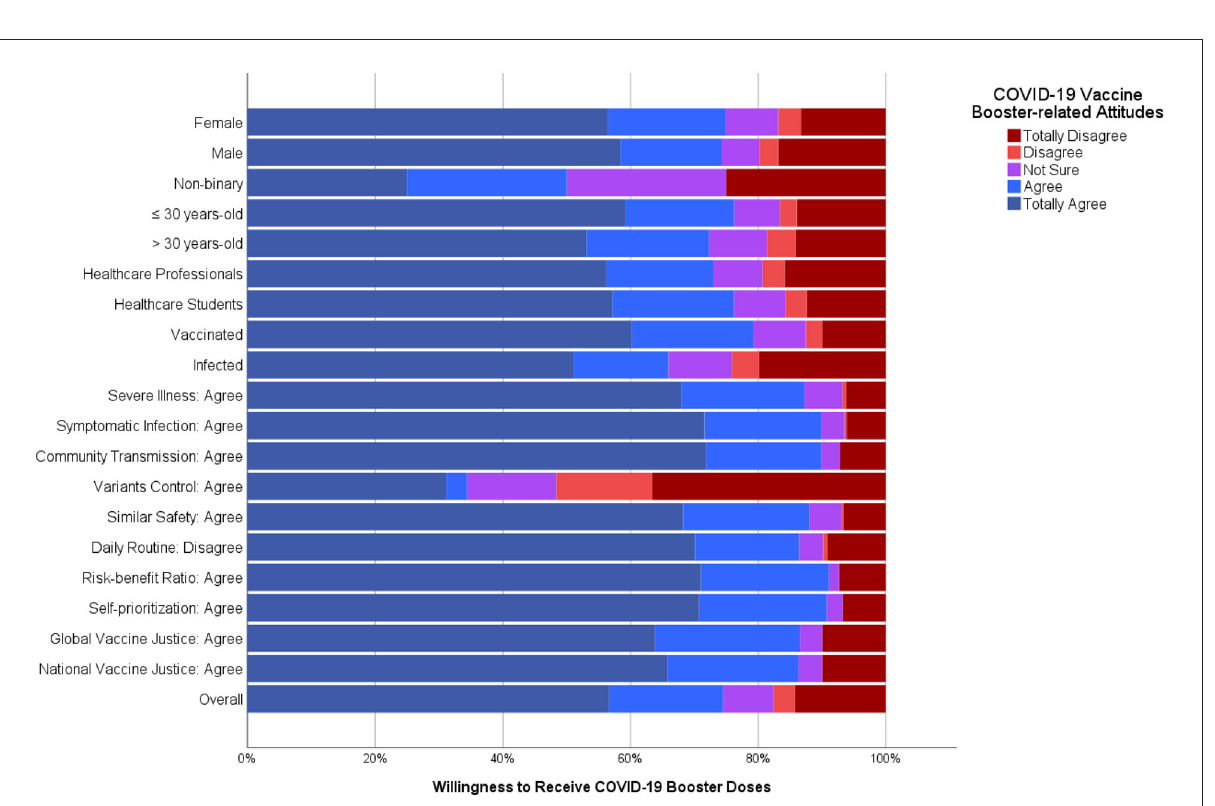
significant difference ( Sig . < 0.001) between triple vaccinated participants (76.9%) and their counterparts (43.4%) and with